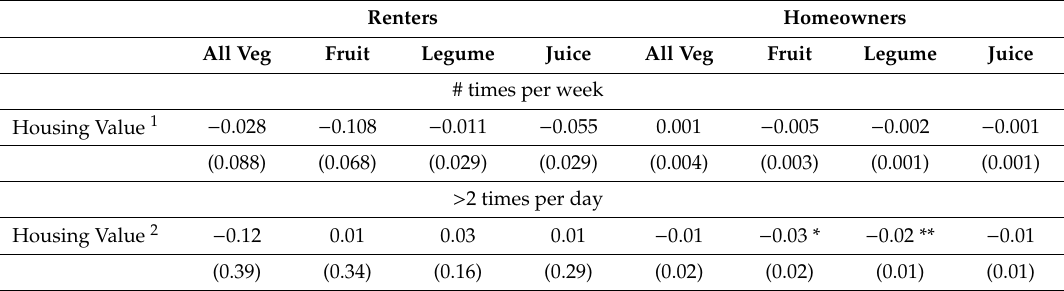
Table 2. Marginal e ff ects of housing value on consumption of four food categories, stratified by home ownership status. Renters Homeowners All Veg Fruit Legume Juice All Veg Fruit Legume Juice # times per week Housing Value 1 − 0.028 − 0.108 − 0.011 − 0.055 0.001 − 0.005 − 0.002 − 0.001 (0.088) (0.068) (0.029) (0.029) (0.004) (0.003) (0.001) (0.001) > 2 times per day Housing Value 2 − 0.12 0.01 0.03 0.01 − 0.01 − 0.03 * − 0.02 ** − 0.01 (0.39) (0.34) (0.16) (0.29) (0.02) (0.02) (0.01)